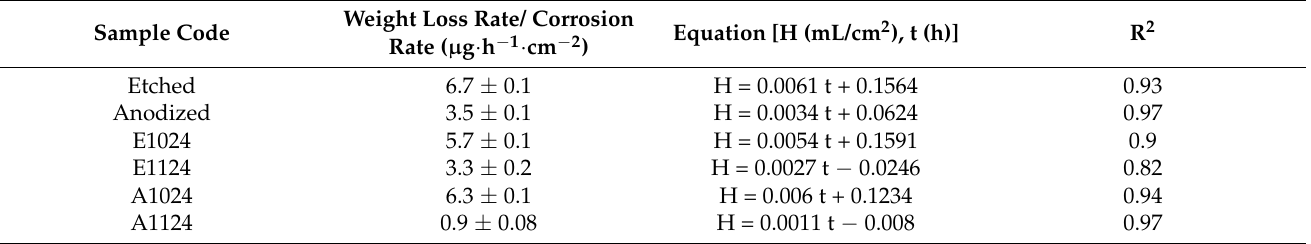
Table 5. Weight loss rate and equations of fitted line for hydrogen evolution experimental